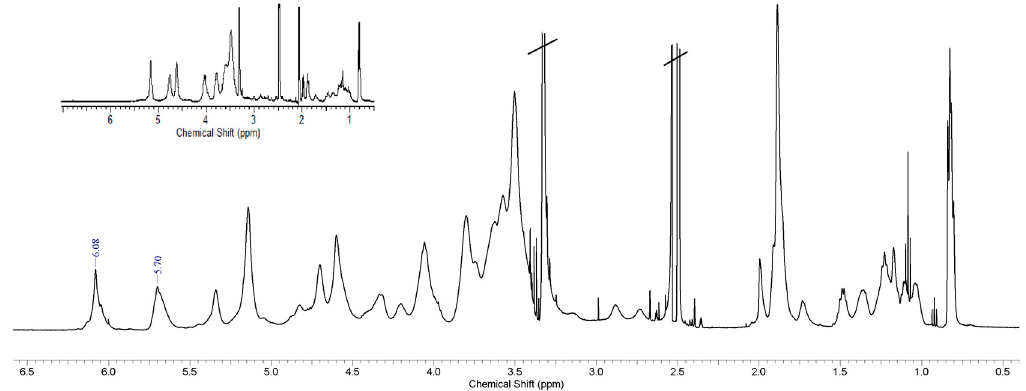
Figure 3. 1 H-NMR Spectra of INVITEMA conjugate in DMSO- d 6 , in the insert the INVITE spectrum before MA functionalization.